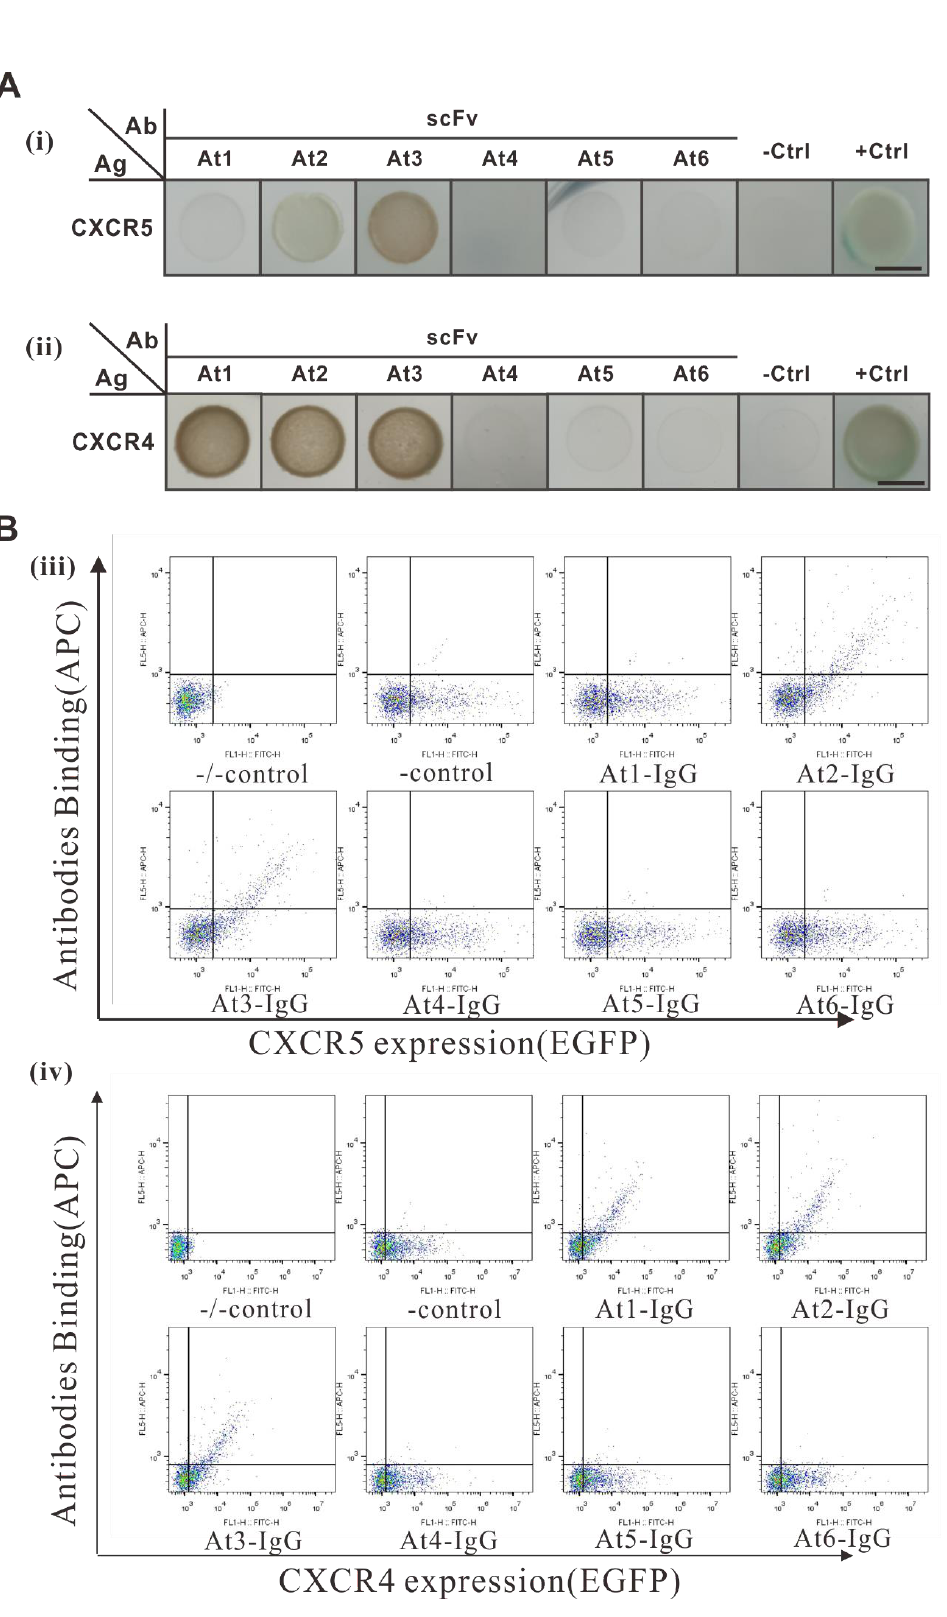
Figure 6. Antibody specificity detection in the AACD system. ( A ) Detection of specific antigen-antibody interaction by the AACD system. Six scFv, including At1 and At2 against CXCR4, At3 against CXCR5, and At4, At5, and At6 against other antigens, were tested for their specificity against CXCR4 (i) or CXCR5 (ii). CXCR4, CXCR5, and scFv sequences were